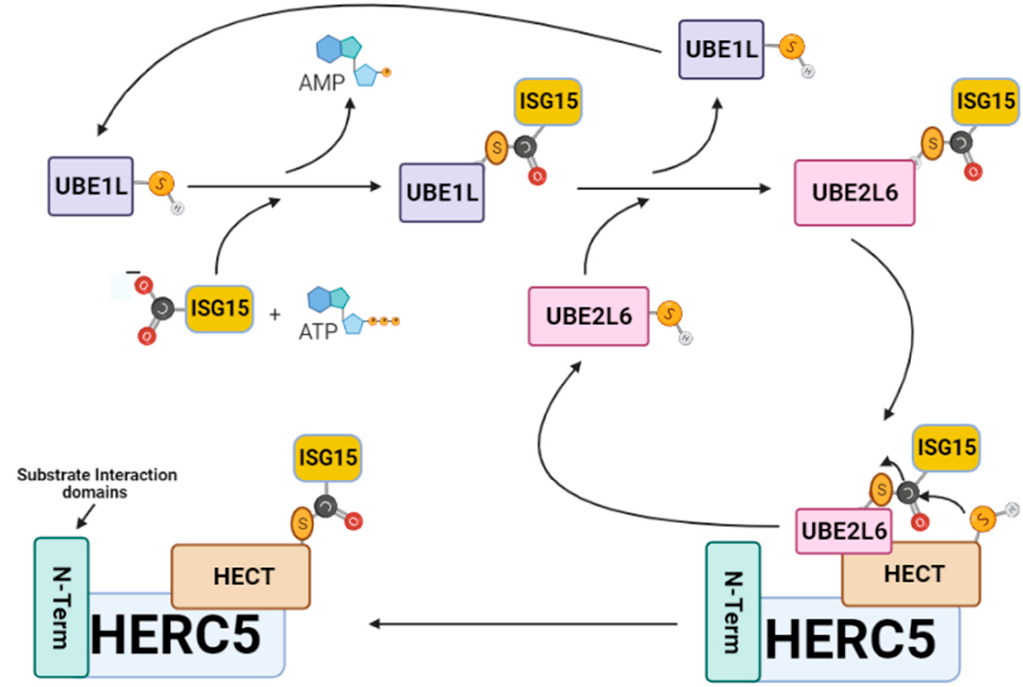
Figure 2. The ISGylation signaling pathway. ISG15 is sequentially transferred from UBE1L to UBE2L6, then to HERC5 before its attachment to a viral protein. HERC5 is responsible for catalyzing the specific covalent attachment of ISG15 onto viral target proteins through the formation of a stable isopeptide bond between the C -terminus of ISG15 and the ε -amino group on the lysine viral protein target. This figure was created with Biorender™.